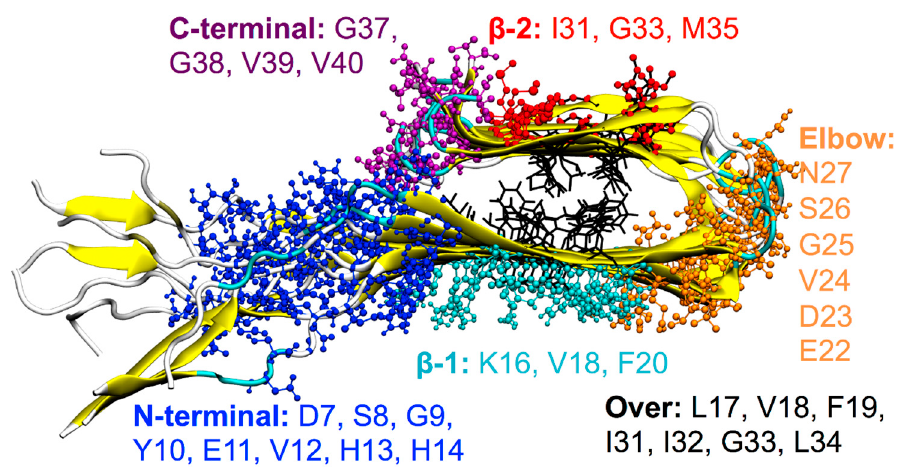
Figure 3. Ball-and-stick representation of the ligand binding sites obtained by REMD. Amino acids (single-letter code) involved in the interactions are reported for each binding site with different colors: Amino acids belonging to the N-terminal site are in blue, to the the β -1 site in cyan, to the Elbow site in orange, to the β -2 site in red, to the C-terminal site in purple, and to the Over site in black).